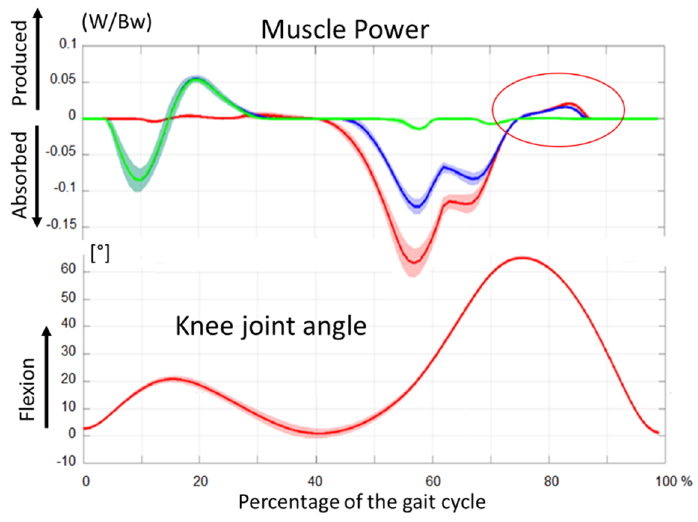
Figure 2. Inverse dynamic simulation. Red line = power of RF with normal activity. Green line = power of all vasti with normal RF activity. Blue line = power of all vasti when RF is paralyzed (note that green line and blue line overlap during the stance phase, since RF power is negligible in this phase, and the vasti do not change their activity. Encircled: the need for positive power at the beginning of knee extension is evidenced. Below: Knee joint angle along the stride cycle, where flexion is positive and extension is negative.